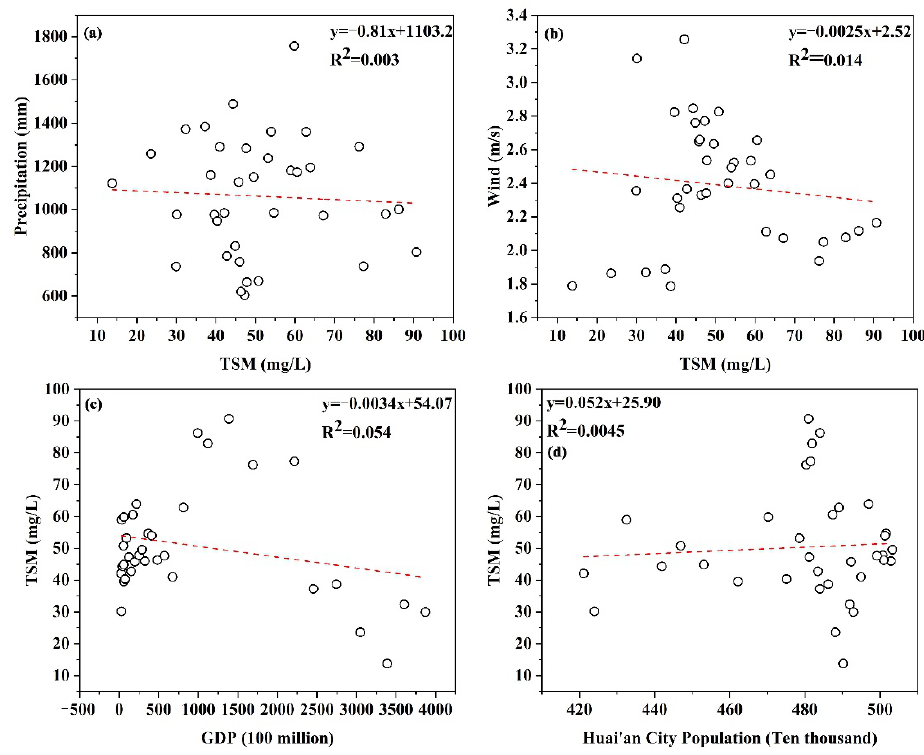
Figure 10. ( a ) Linear relationship between TSM and precipitation; ( b ) linear relationship between TSM and wind speed; ( c ) linear relationship between TSM and GDP; ( d ) linear relationship between TSM and population.